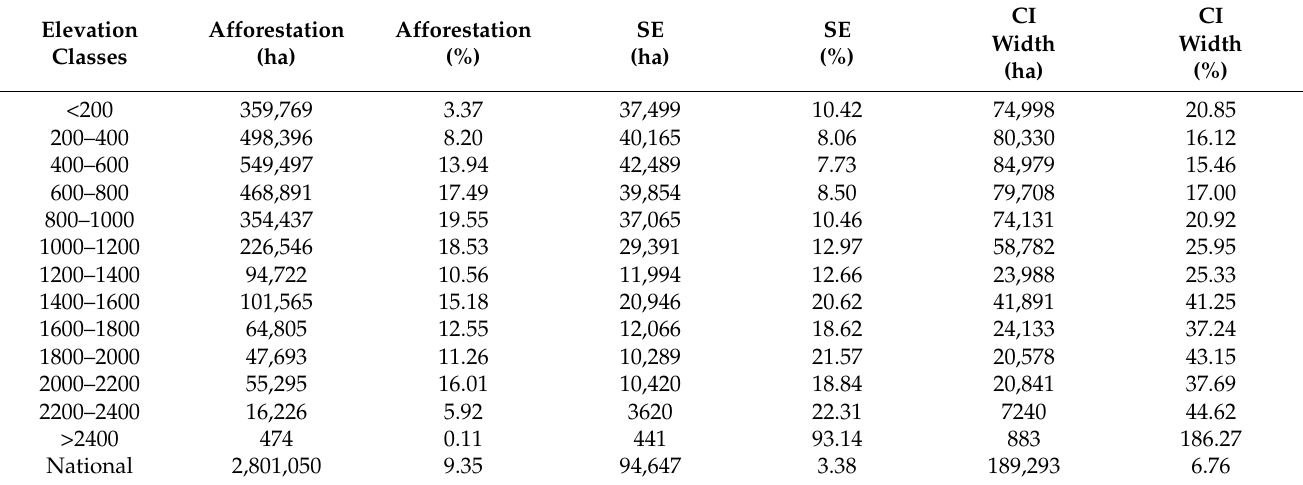
Table A4. Stratified area estimates for elevation classes. This table shows the afforestation estimates for each elevation class in ha and percentage, with the associated standard error and 95% confidence interval width.